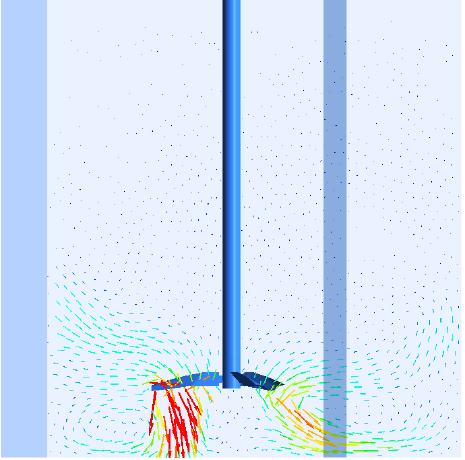
Figure 8. Velocity vectors on baffle-impeller blade plane in a full scale stirred tank.